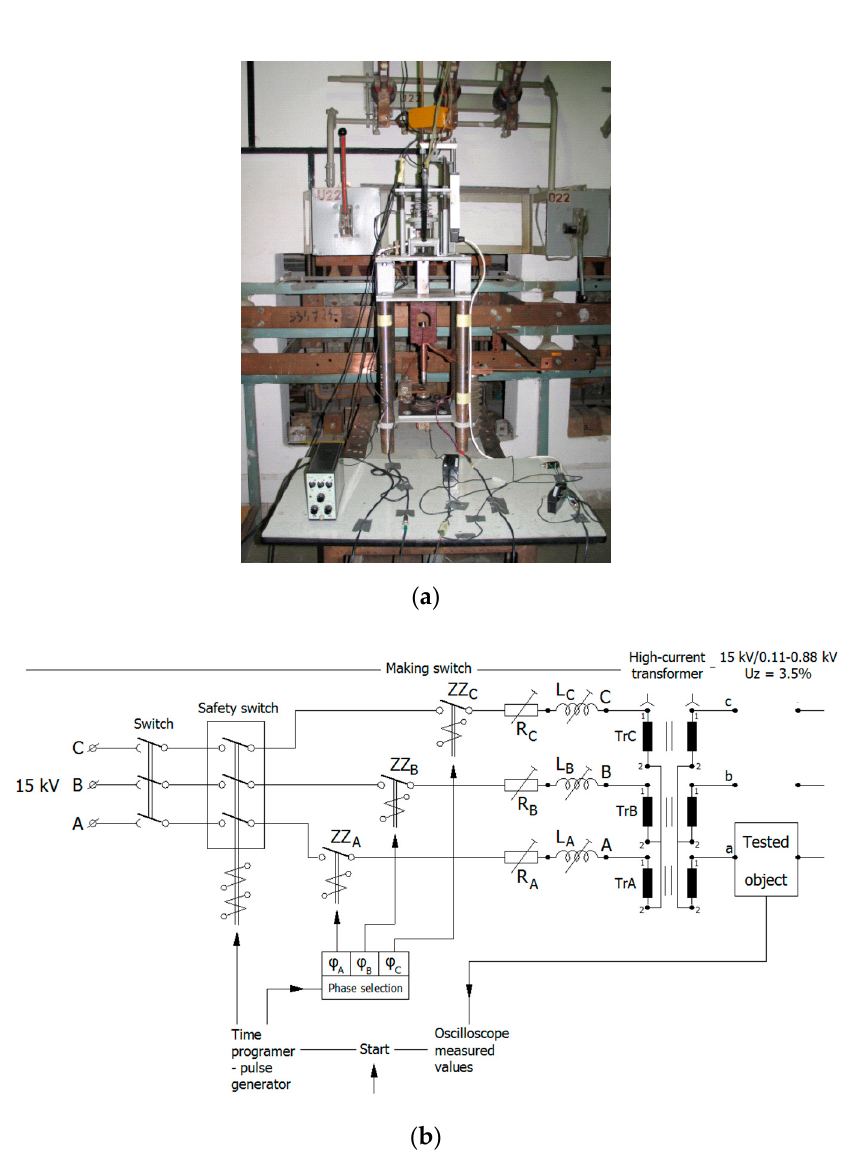
Figure 32. Laboratory setup for simulation validation: ( a ) Laboratory stand and ( b ) short-circuit system in the Short Circuit Laboratory, Electrical Faculty, Warsaw University of Technology.